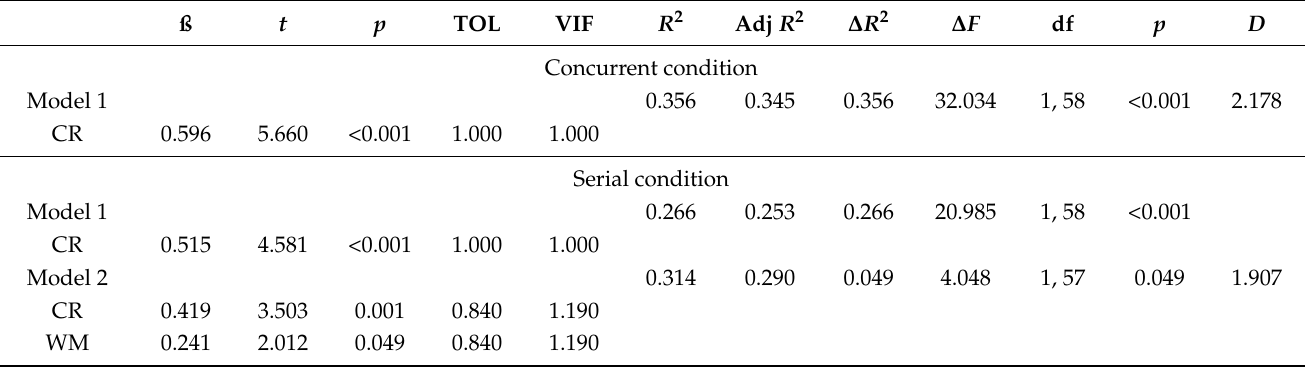
Table 5. Results of the stepwise regression analyses for canonical sentences.